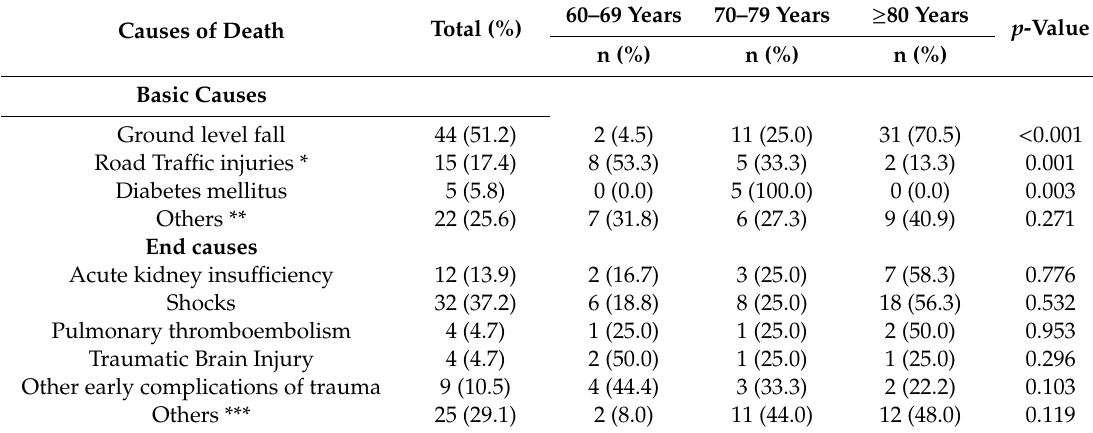
Table 2. Causes and end of deaths of hospitalized elderly with bone fracture, according to age group in Goi â nia, Central Brazil (2016 /